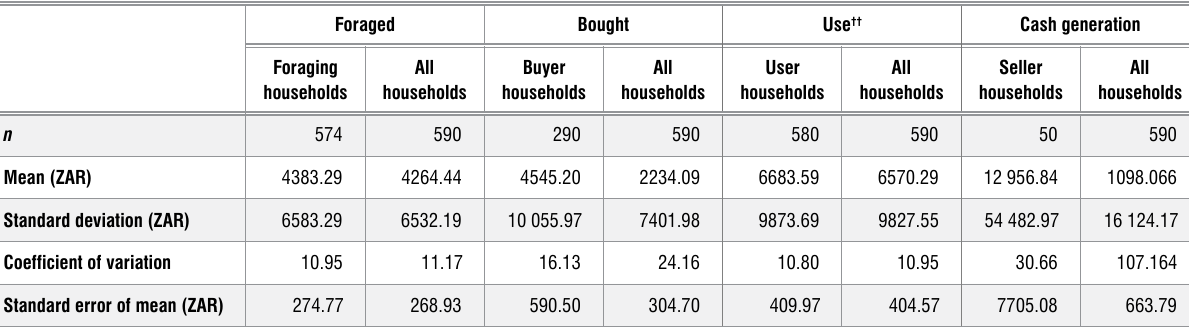
Standard deviation